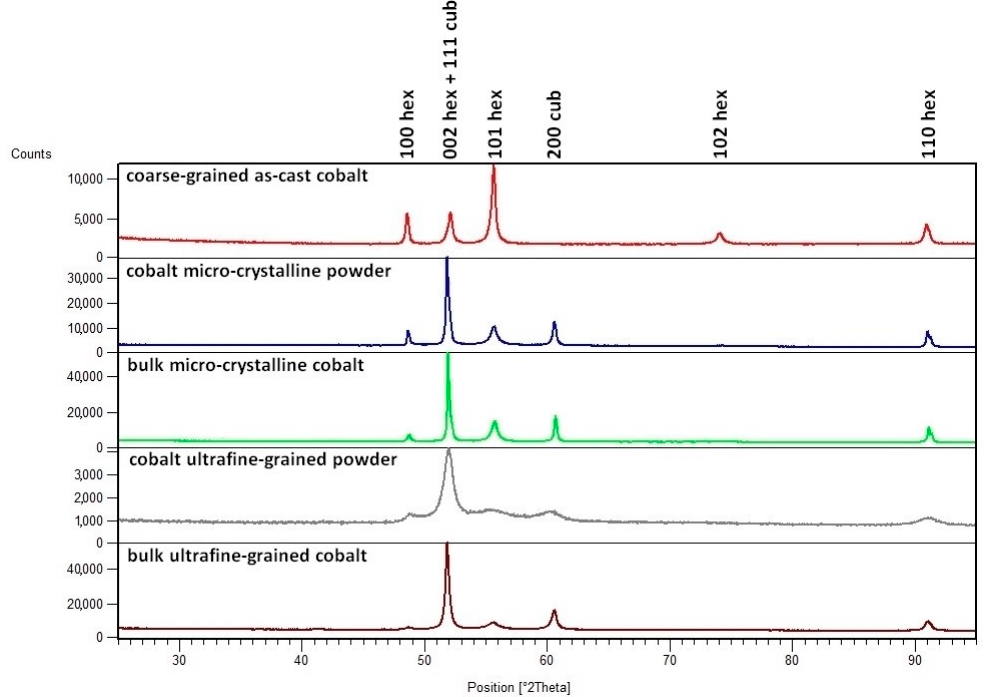
Figure 3. XRD patterns of the powders and the bulk materials.